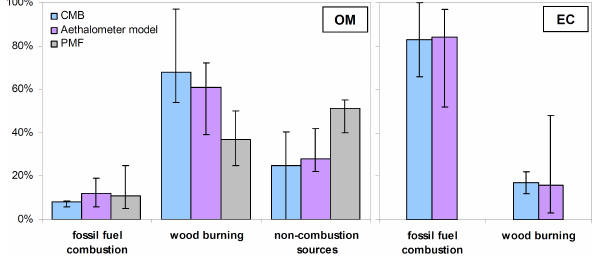
Figure 11 Fig. 11. Contributions of the three major sources (i.e., fossil fuel combustion, wood burning and non-combustion sources) to total fine organic matter (OM) and elemental carbon (EC) ob- tained from the different source apportionment models. The CMB and Aethalometer models were computed for PM 2 . 5 carbonaceous aerosols, while PMF analyses were achieved on the organic data matrix obtained by the AMS for submicron aerosols. For PMF anal- yses, HOA, pBBOA and OOA were assumed here to correspond to fossil fuel combustion, wood burning and non-combustion sources respectively. Mean contribution presented were obtained for peri- ods when CMB, PMF and Aethalometer modelling studies over- Fig. 10. Inter-comparisons of the time series of OM wb concen- lapped, i.e., from 17 January 2009, 18:00 to 29 January 2009, 18:00 Figure 10 trations calculated by the different source apportionment models. (with the exceptions of 22 January 2009, 18:00 to 23 January 2009, (a) Outputs of the CMB and Aethalometer models (12h-averaged 06:00 and of 24 January 2009, 18:00 to 25 January 2009, data, from 17 January 2009, 18:00 to 30 January 2009, 06:00). (b) Outputs of the AMS-PMF and Aethalometer models (15min- averaged data, from 14 January 2009, 16:00 to 29 January 2009, 23:30).